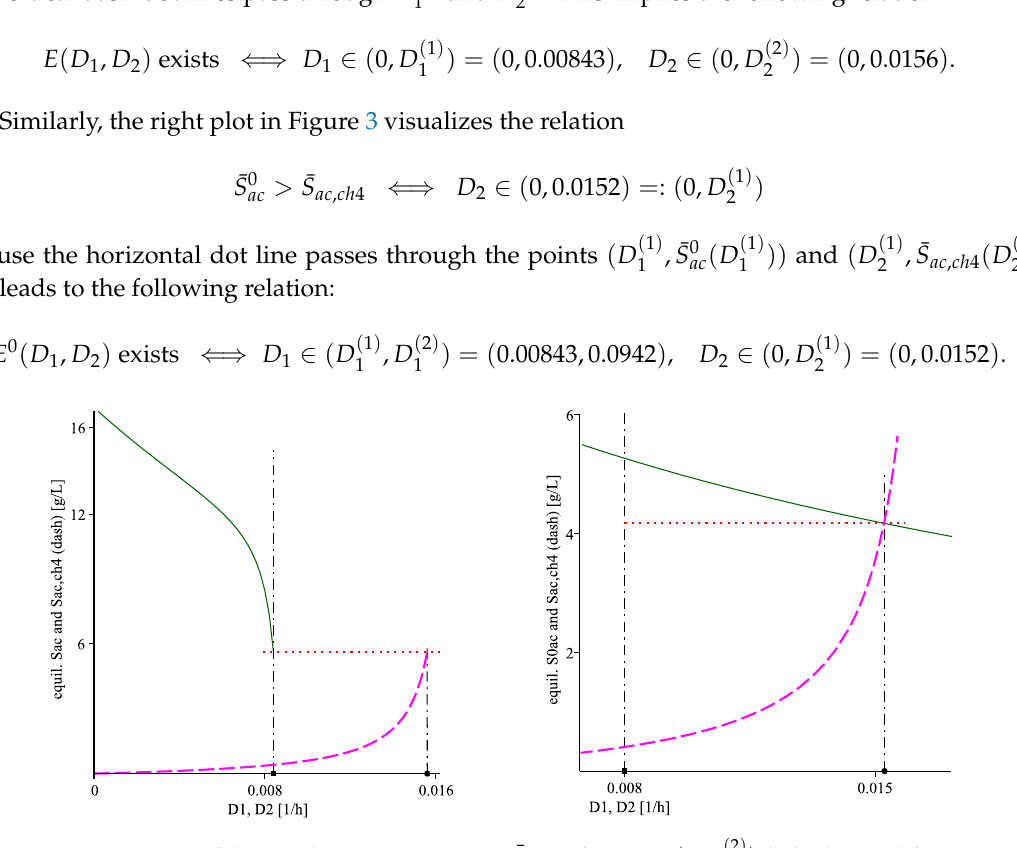
Figure 3. Existence of the equilibrium component ¯ S ac , ch 4 for D 2 ∈ ( 0, D ( 0, D ( 1 ) ) (right 2